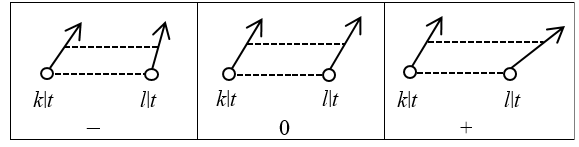
Figure 1. Illustration of the RTC relations. Table 1. The relationship between the RTC relations and the three types of interaction patterns.